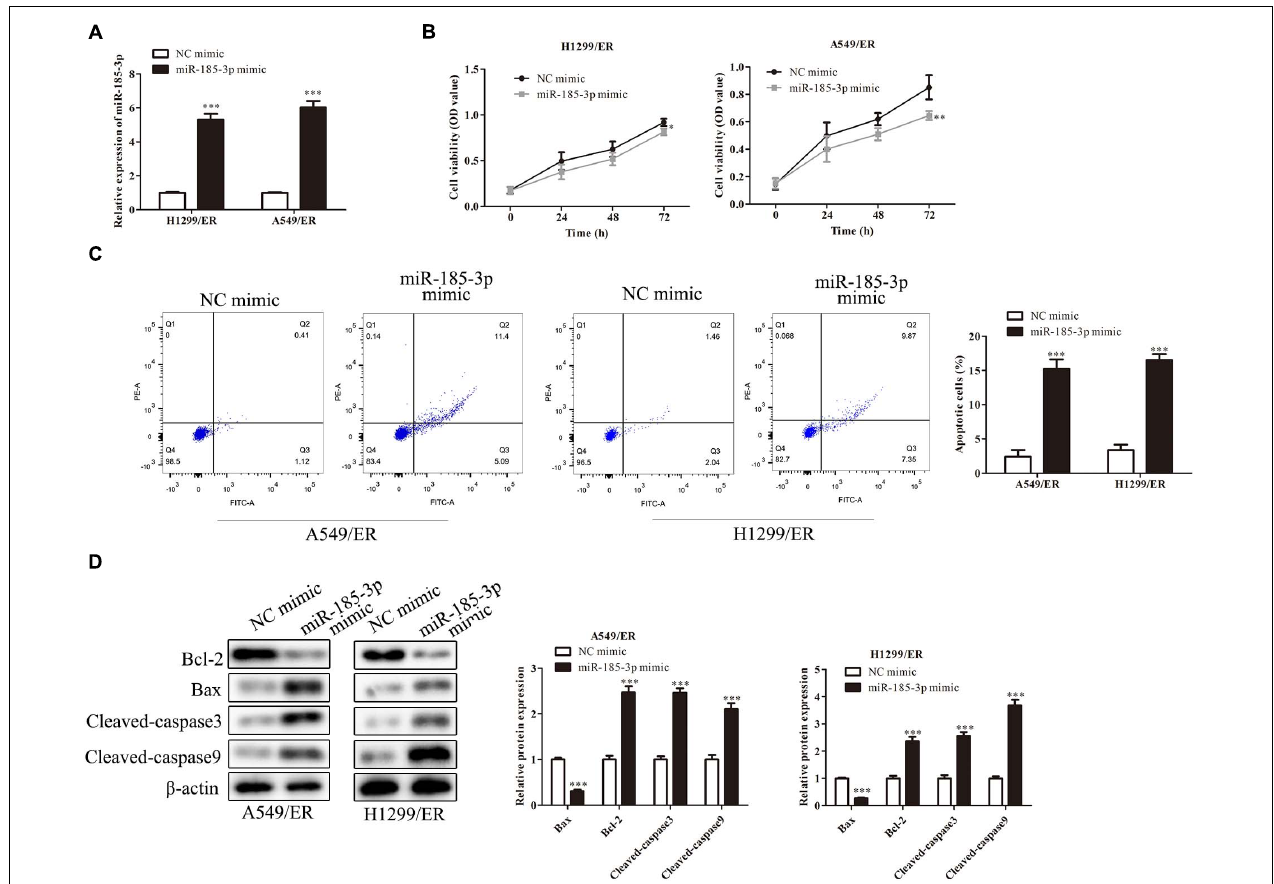
FIGURE 2 | MiR-185-3p suppresses cell proliferation and induces apoptosis. (A) The level of miR-185-3p was determined by qRT-PCR in H1299/ER and A549/ER cells. (B) Cell viability was determined by Cell Counting Kit-8 (CCK8) assay in H1299/ER and A549/ER cells at 24, 48, and 72 h. (C) Cell apoptosis was determined by flow cytometry assay in H1299/ER and A549/ER cells. (D) The levels of apoptosis-related proteins Bcl-2, Bax, Cleaved-caspase3, and Cleaved-caspase9 were investigated by Western blot in H1299/ER and A549/ER cells. Data were shown as mean ± SD. * p < 0.05; ∗∗ p < 0.01; ∗∗∗ p < 0.001.